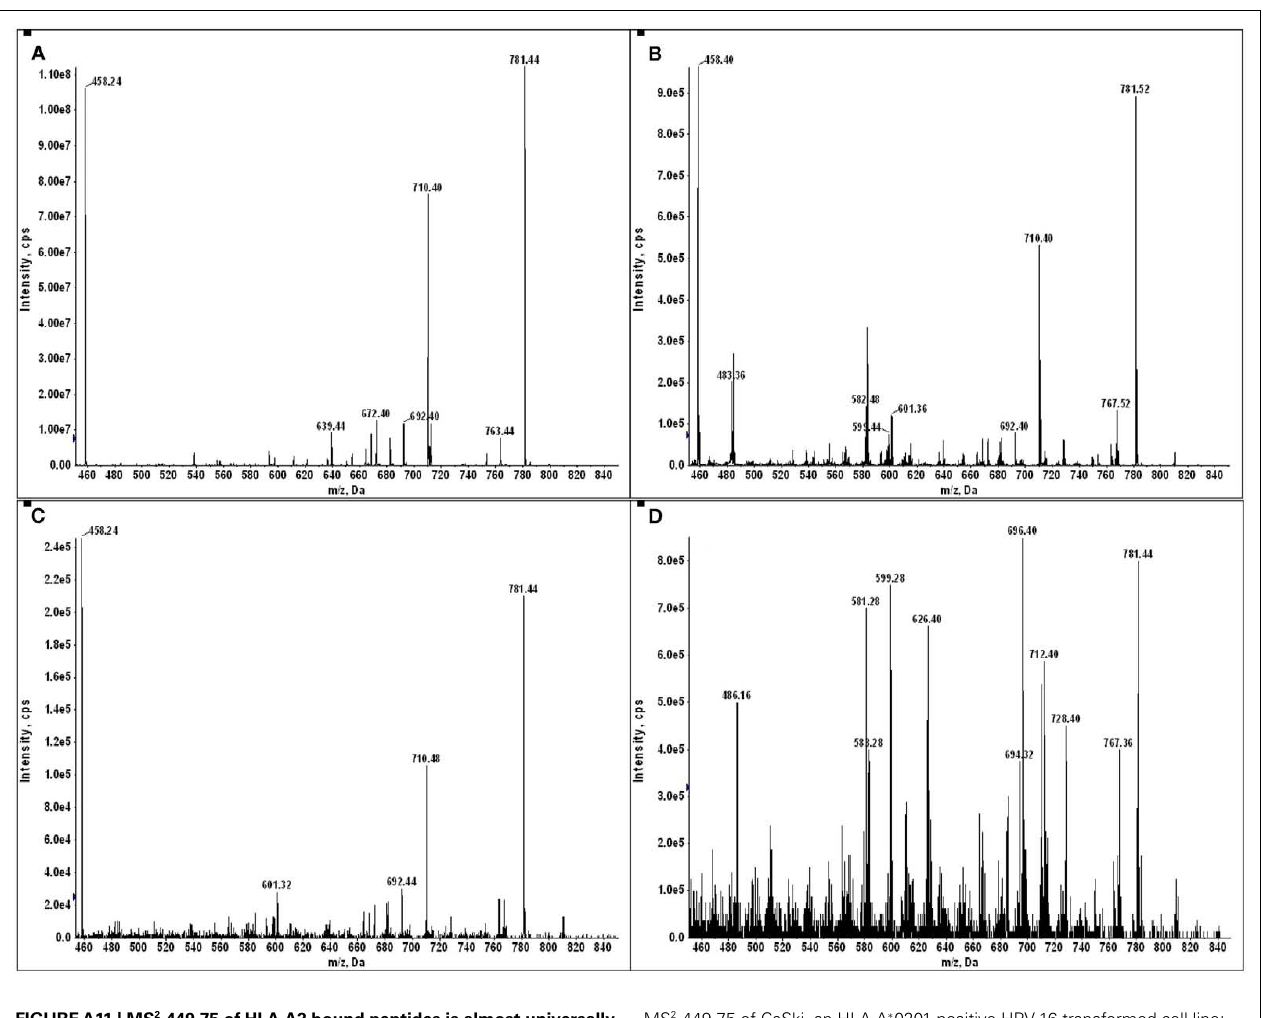
MS 2 449.75 of CaSki, an HLA-A ∗ 0201 positive HPV-16 transformed cell line; (C) MS 2 449.75 of an HLA-A ∗ 0201 positive respiratory epithelial cell line BEAS; (D) MS 2 449.75 of tumor sample KTS8. Note in particular the lack of the major m / z 458 fragment in (D)